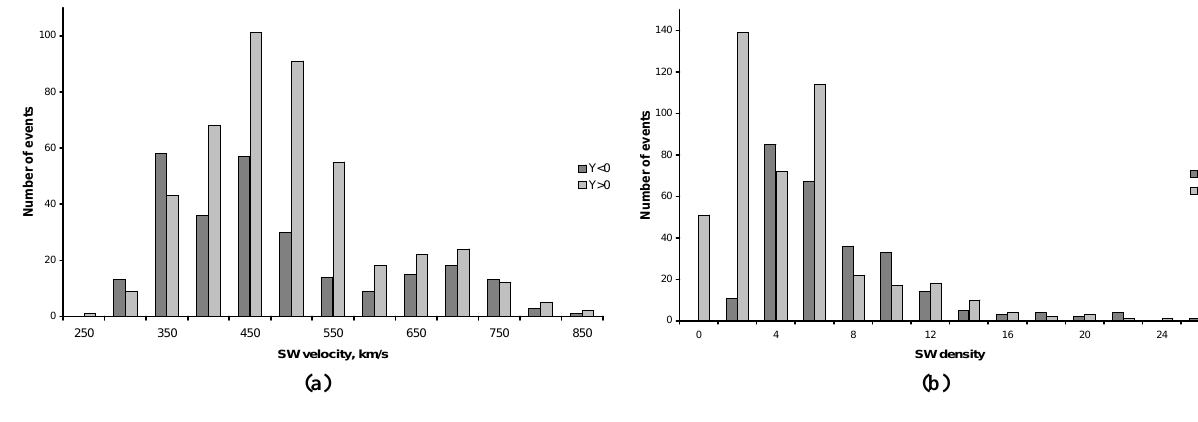
Fig. 5. Histograms of averaged solar wind velocities (a) and densities (b) during selected magnetosheath intervals.